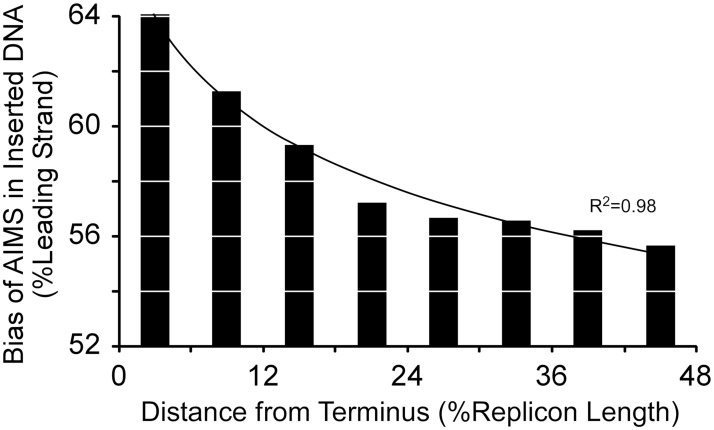
Strand-bias of AIMS in recently acquired genes as a function of the distance of the inserted DNA from the terminus.The data were fit to a negative exponential distribution.